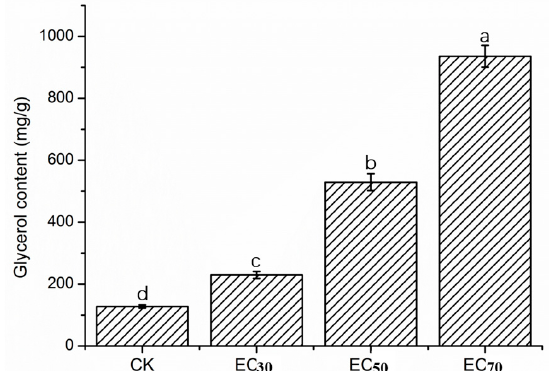
Figure 3. Glycerol content of mycelia of FON with or without cuminic acid treatment at concentrations of EC 30 (5.6 μ g/mL), EC 50 (22.53 μ g/mL) and EC 70 (91.3 μ g/mL). Bars denote the stand error of three experiments. Data represents means of three replicates with standard deviation. Data (means ± SD, n = 3) followed by the same letters in the row show no significant differences (small letters, p < 0.05).